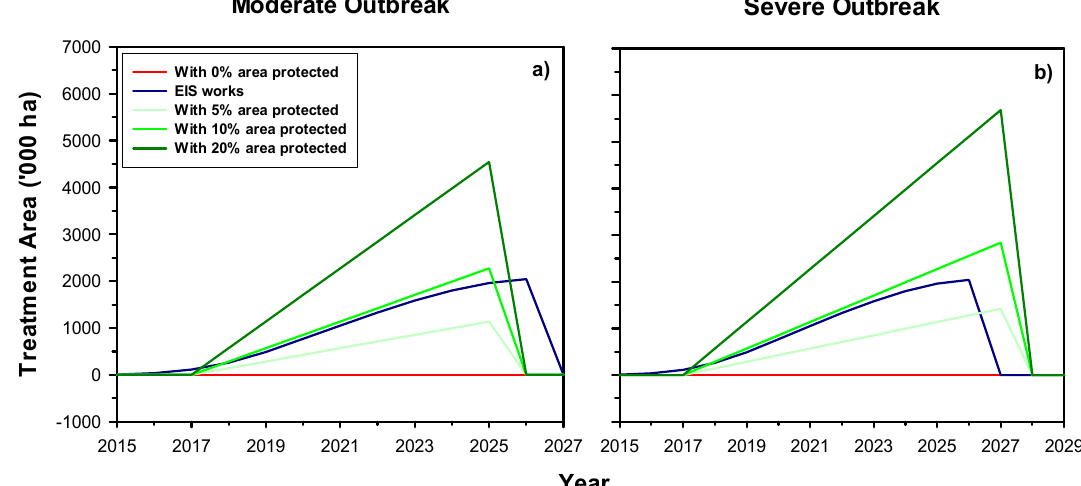
Figure 3. Projected total treatment area for Crown land in New Brunswick under ( a ) moderate and ( b ) severe SBW outbreak and protection scenarios.